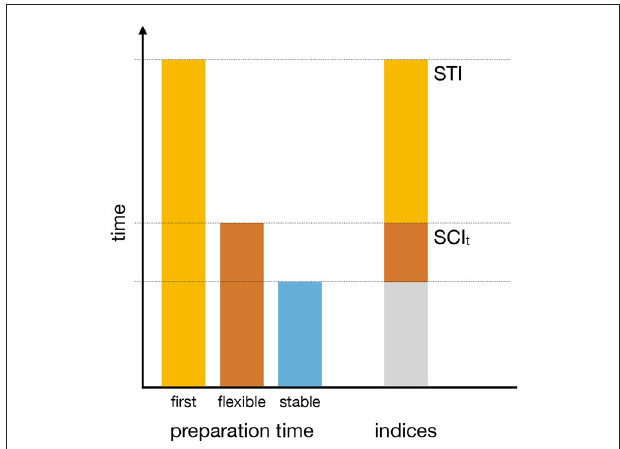
FIGURE 2 | Schematic representation of the derived time performance indices. The left side of the figure illustrates the estimates of preparation times when faced with a rule for the first time ( first ), during performance in flexible task mode ( flexible ), and during performance in stable task mode ( stable ). The right side of the figure shows that the Switching Cost Index ( SCI t ) reflects the additional time required to switch between complex task rules compared to stable task rule maintenance. The Setup Time Index ( STI ) reflects the additional time required to set up complex task rules when they are encountered for the first